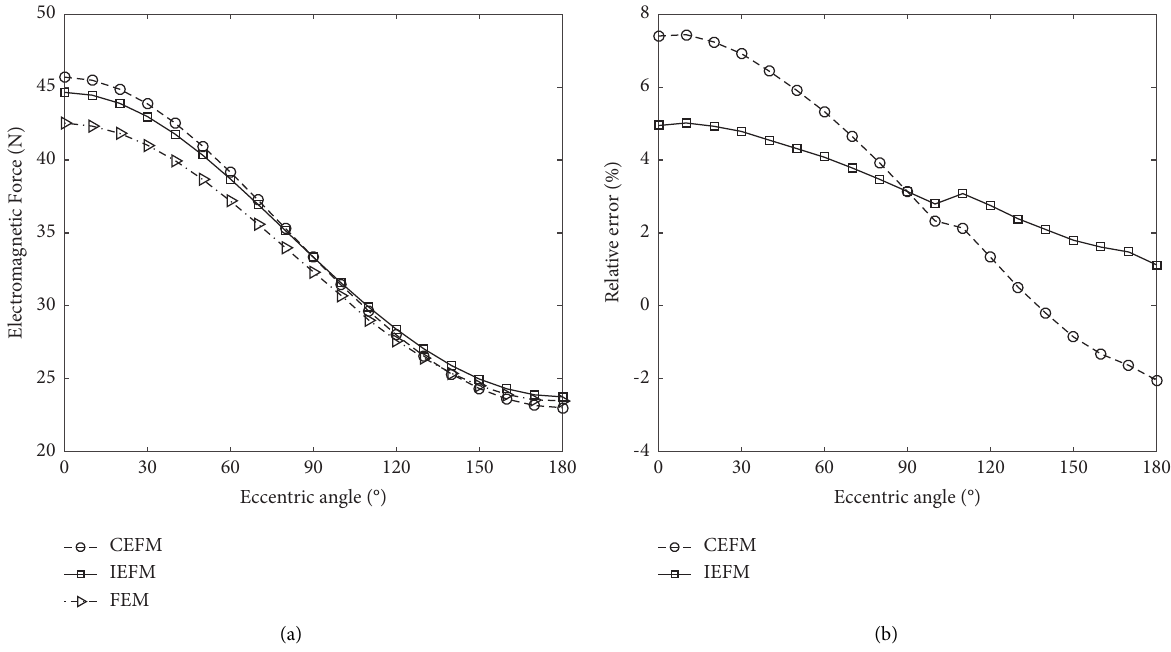
Figure 4: Result comparison between IEF and CEF with different eccentric angles. (a) Electromagnetic force. (b) Relative error.